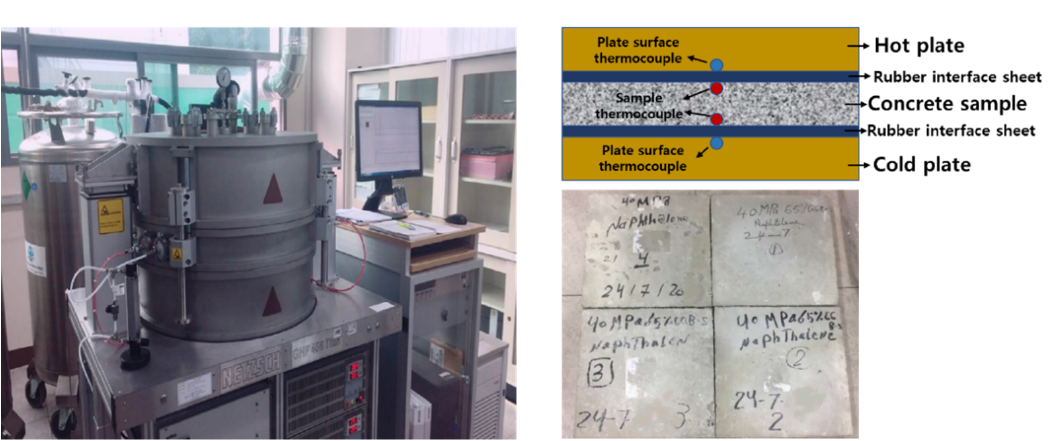
Figure 10. GHP (Guarded Hot Plate) 456 Titan and set-up of the sample, thermal sensors and plate. Table 13. Test results of thermal conductivity.